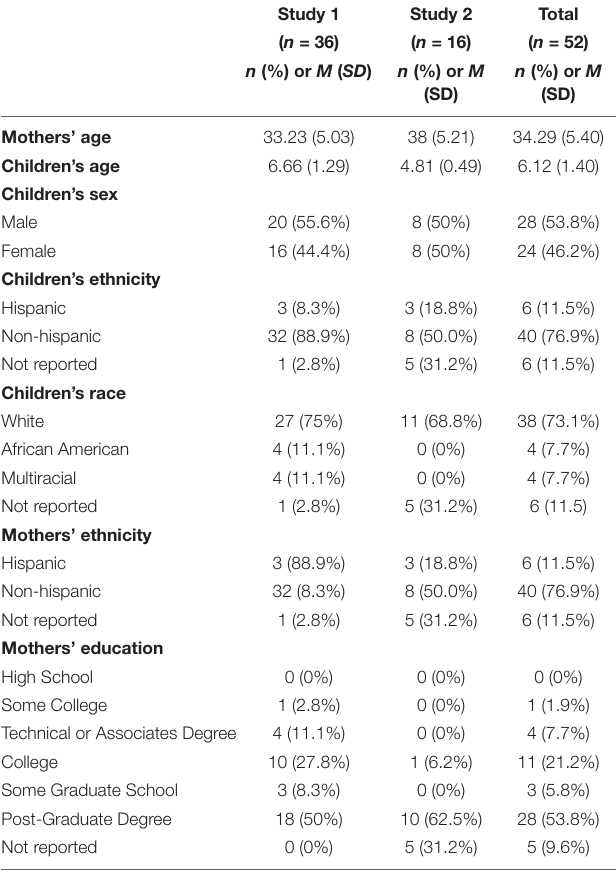
TABLE 1 | Demographics of participants in Study 1 and Study